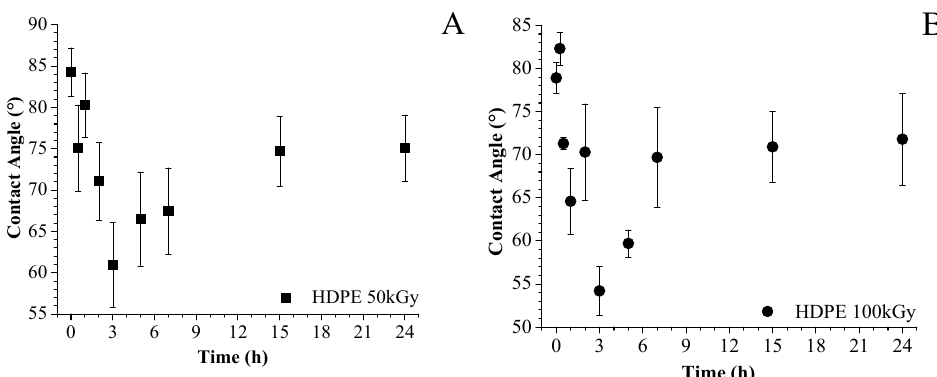
a b c d e f g h F 1080 Figure 2. ATR–FTIR spectra (in different regions of infrared absorption bands characteristic of chi- tosan) of irradiated HDPE at 50 (A, B, and C) and 100 kGy (D, E, F) after different grafting reaction times: ( b ) 30 min, ( c ) 1 h, ( d ) 2 h, ( e ) 3 h, ( f ) 5 h, ( g ) 10 h, and ( h ) 15 h. Line ( a ) represents irradiated HDPE. Interestingly, all these bands characteristic to chitosan chemical changes increase in intensity with increasing the reaction time, reaching a maximum after 3 h and then de- creasing for longer reaction time. Relevant differences cannot be found among the irradi- ated samples at 50 and 100 kGy, except for the fact that the bands appear more intense in the sample irradiated at 100 kGy. This behaviour is also confirmed by the wettability measurement. In fact, the contact angle values (Figure 3A and 3B) decrease by increasing reaction time and achieving a minimum value after three hours of reaction. Then, the contact angles slightly increase